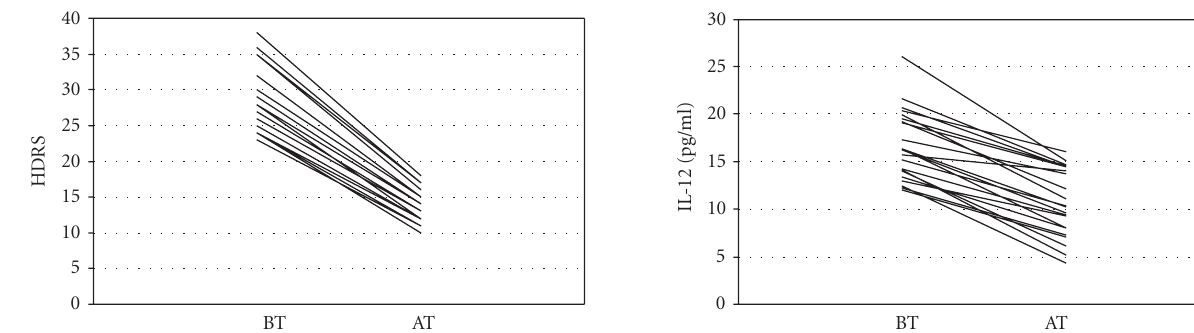
Figure 1: Hamilton depression rating scale (HDRS) levels before (BT) and after (AT) sertraline treatment.